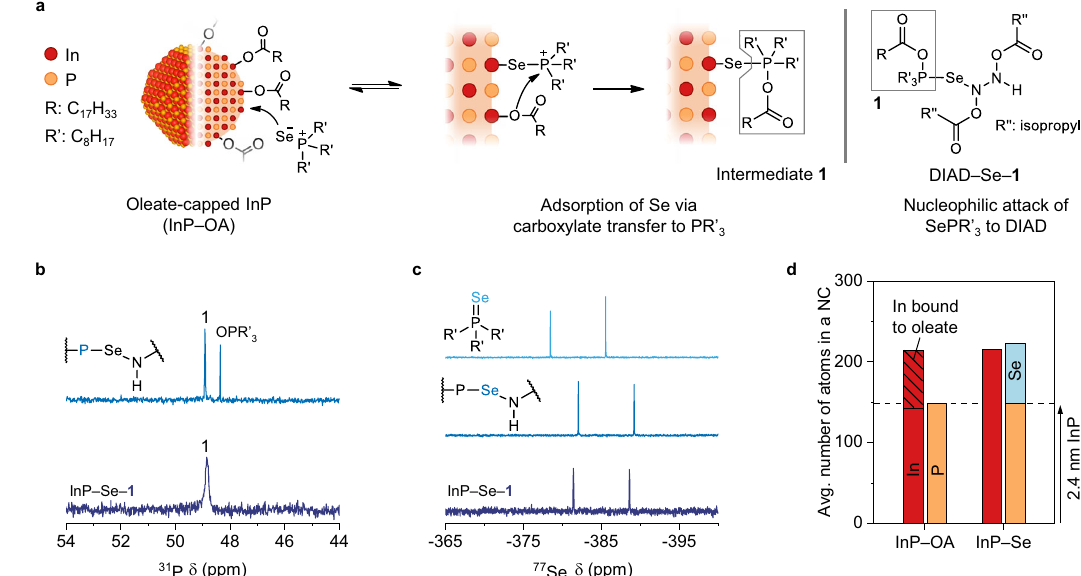
Fig. 1 | Adsorption of Se from trioctylphosphine selenide to oleate-capped InP NCs. a Adsorption pathway of Se to oleate-capped InP NCs (InP – OA) via oleate transfer from the surface to trioctylphosphine selenide (SePR ’ 3 ), yielding oleoy- loxytrioctylphosphonium (Intermediate 1 ). As shown on the right, this compound can be separately prepared by the nucleophilic addition of SePR ’ 3 to diisopropyl azocarboxylate (DIAD) in the form of DIAD – Se – 1 . b 31 P NMR spectra of InP – Se – 1 (deep blue) and oleoyloxytrioctylphosphonium – DIAD selenide (DIAD – Se – 1 , blue).